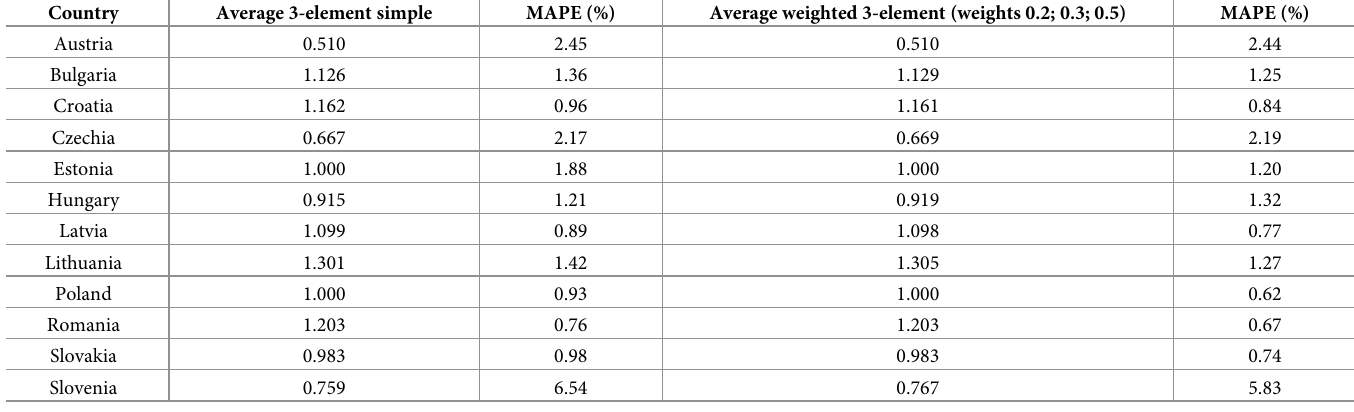
Table 8. Synthetic economic anchor measure for